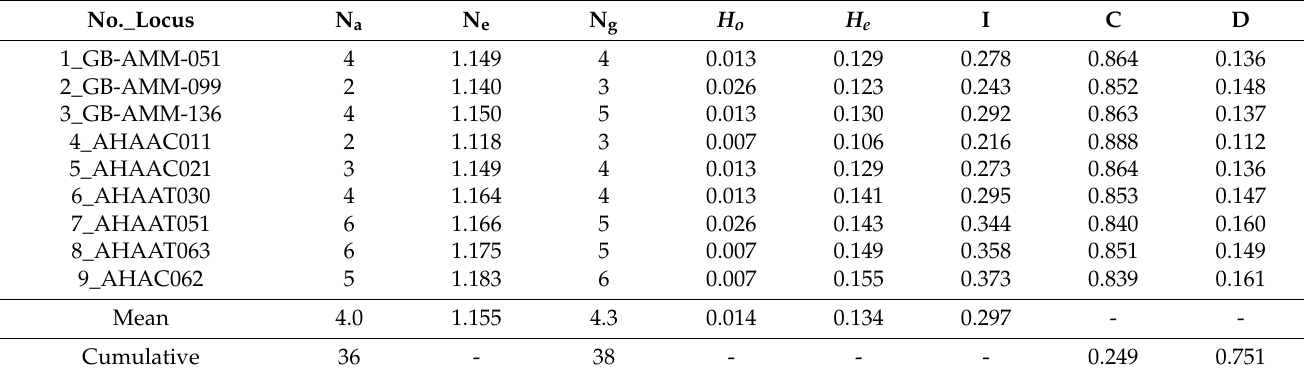
Table 2. Genetic diversity parameters calculated for each of the nine microsatellite loci analyzed in 152 black amaranth samples. N a : number of alleles, N e : effective number of alleles, N g : number of genotypes, H o : observed heterozygosity, H e : expected heterozygosity, I: Shannon information index, C: probability of coincidence, and D: discrimination